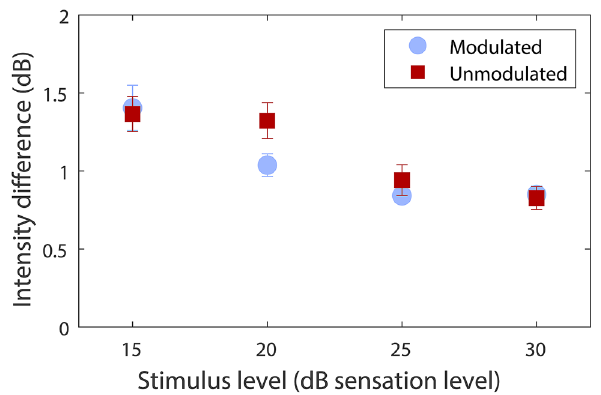
Figure 2. Tactile intensity difference discrimination thresholds across the wrists for speech amplitude envelope modulated (light blue circles) and unmodulated (dark red squares) sinusoids, in young adults. Thresholds are shown as a function of stimulus level above the participant’s detection threshold (sensation level). Error bars show the standard error of the mean. This figure was generated using MATLAB R2019a (http://www.mathw orks.com/produ cts/matla